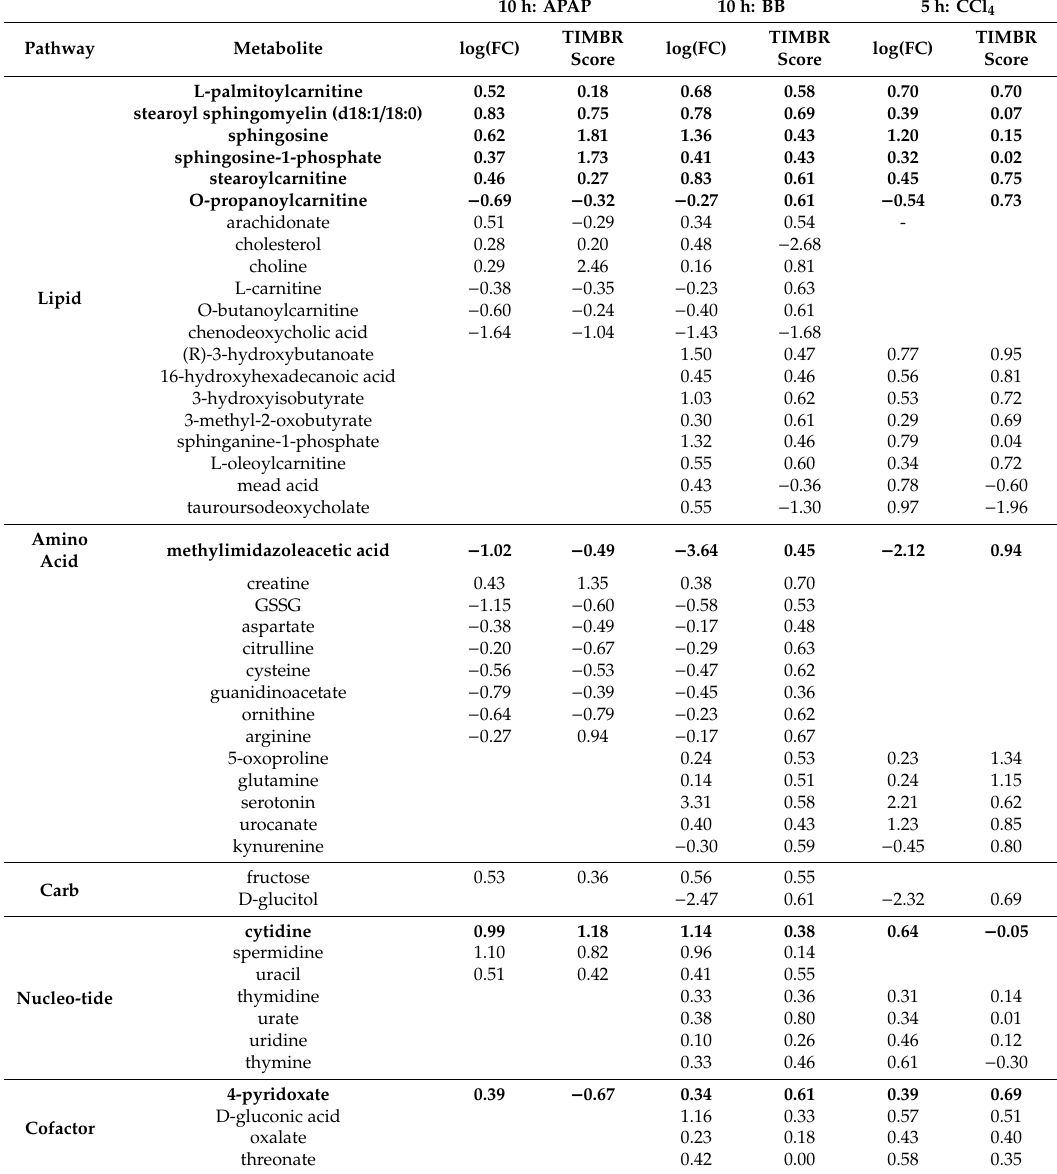
Table 2. Summary of the model predictions for significantly altered plasma metabolites in the injury- specific pathways that are common for at least two toxicants. Metabolite entries in bold indicate a consistent direction of fold change among all three